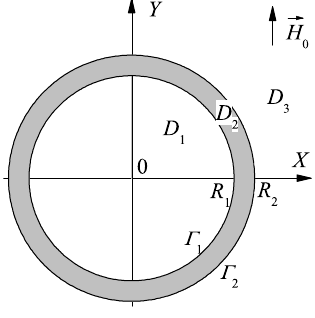
Figure 1. The problem setting: D 1 corresponds to the internal nonmagnetic medium, D 2 corresponds to the ferrofluid, and D 3 corresponds to the external nonmagnetic